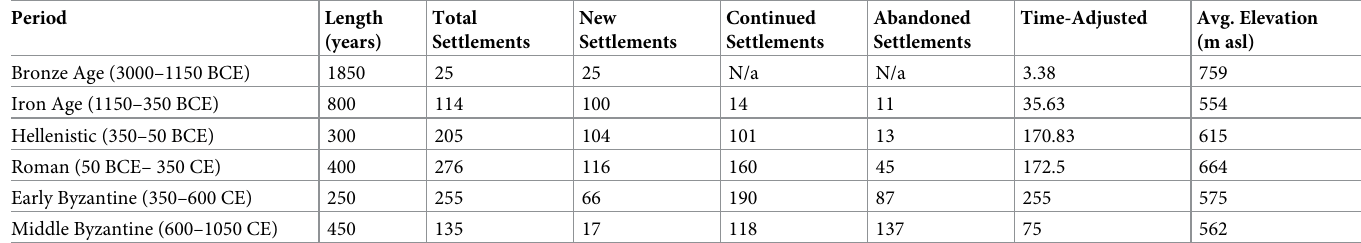
Table 1. Settlement metadata by period. “New” settlements are those with evidence in the period, but no evidence in the preceding period; “Continued” settlements are those with evidence in the period and preceding period; “Abandoned” settlements are those with no evidence in the period, but evidence in the preceding period; time- adjusted settlement numbers are calculated following the methodology of [39, 42].